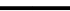
ledet, bliver og blev mættet, bliver og blev frelset!